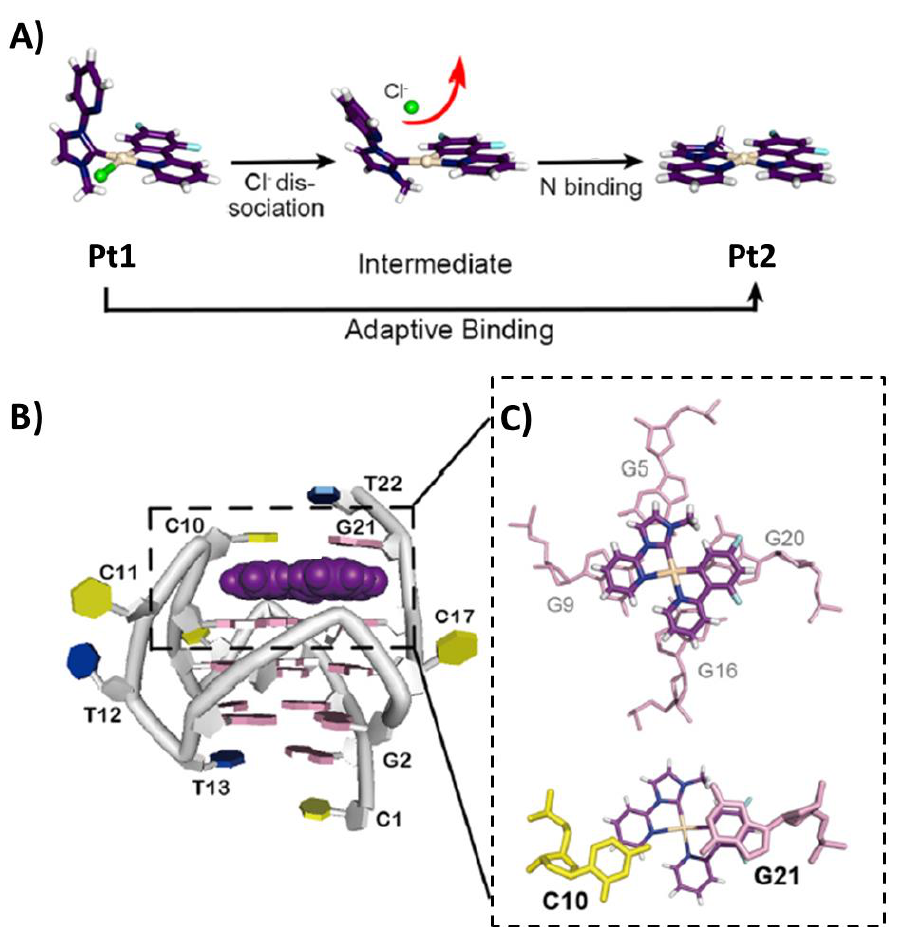
Figure 14. ( A ) Pt1 conversion to Pt2. ( B ) NMR structure of the complex between the unimolecular parallel G-quadruplex VEGF of sequence d(CGGGGCGGGCCTTGGGCGGGGT) and Pt2. 3′ - and 5′ -end of the G-quadruplex are at the top and bottom, respectively. Details of the ligand binding are highlighted in ( C ). Adapted with permission from ref. [97], Copyright 2021 Wiley-VCH GmbH.